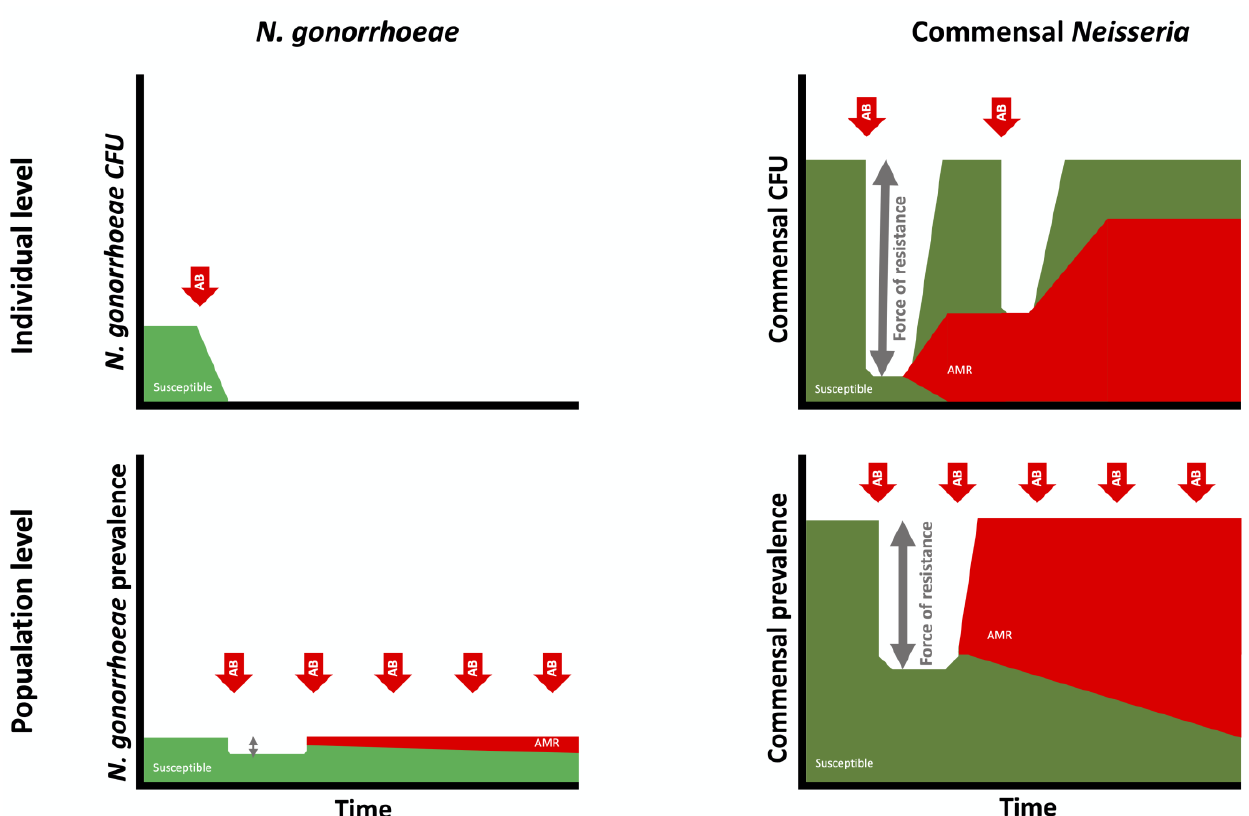
Figure 3. Schematic illustration of the importance of considering the selection of antimicrobial resistance in N. gonorrhoeae ( left ) and commensal Neisseria ( right ) at both the individual ( top ) and population levels ( bottom ). Whereas dual therapy with ceftriaxone/azithromycin (AB; red arrows) eradicates N. gonorrhoeae in an infected individual, it only reduces the abundance of commensal Neisseria . The resilience of commensal Neisseria results in their returning to baseline abundance in a process that selects for resistant isolates. The greater the decline in abundance of commensal abundance, the greater the ‘force of resistance’ (grey arrows). At a population level, high exposure to ceftriaxone/azithromycin will push the prevalence of both N. gonorrhoeae and commensal Neisseria species below the equilibrium prevalences (100% for commensals and 0.1–10% for N. gonorrhoeae , depending on sexual network connectivity). This will select for resistance to these agents in both N. gonorrhoeae and commensal Neisseria . (CFU: colony forming units).